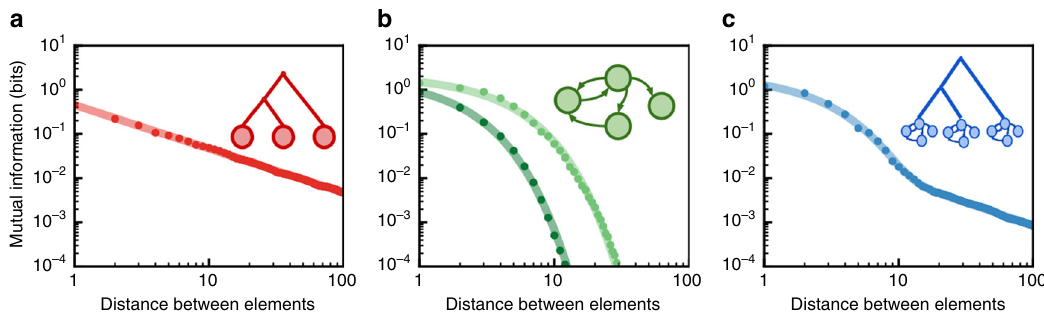
Fig. 2 MI decay of sequences generated by three classes of models. a MI decay of sequences generated by the hierarchically organized model proposed by Lin and Tegmark 3 (red points) is best fi t by a power-law decay (red line). b MI decay of sequences generated by Markov models of Bengalese fi nch song from Jin et al. 31 and Katahira et al. 32 (green points) are best fi t by an exponential decay model (green lines). c MI decay of sequences generated by a composite model (blue points) that combines the hierarchical model (a) and the exponential model (b) is best fi t by a composite model (blue line) with both power-law and exponential